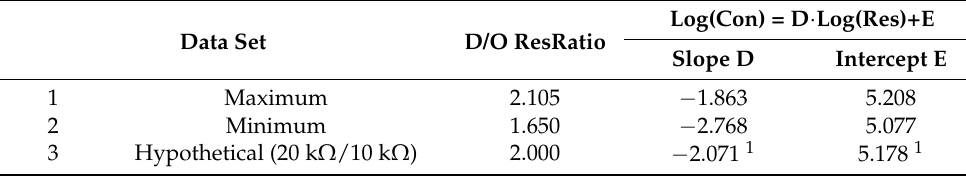
Table 4. Log concentrations, log resistance values, and interpolation of resistance ratio.